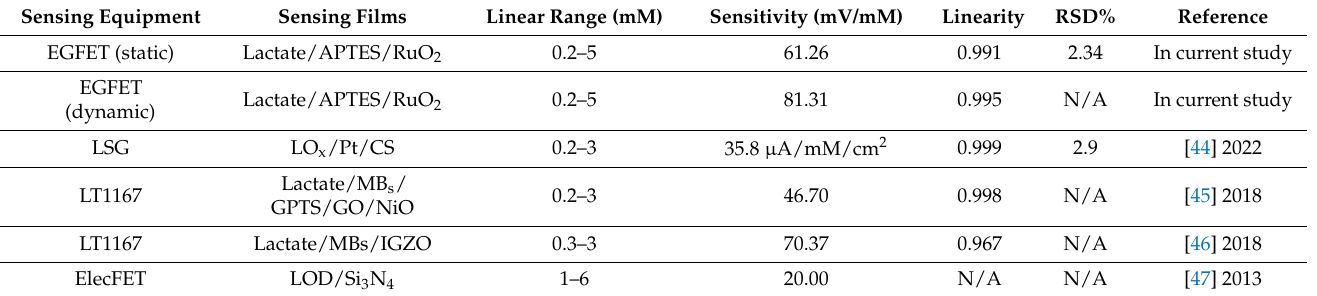
Table 3. Comparisons of the sensing characteristics for diverse LA